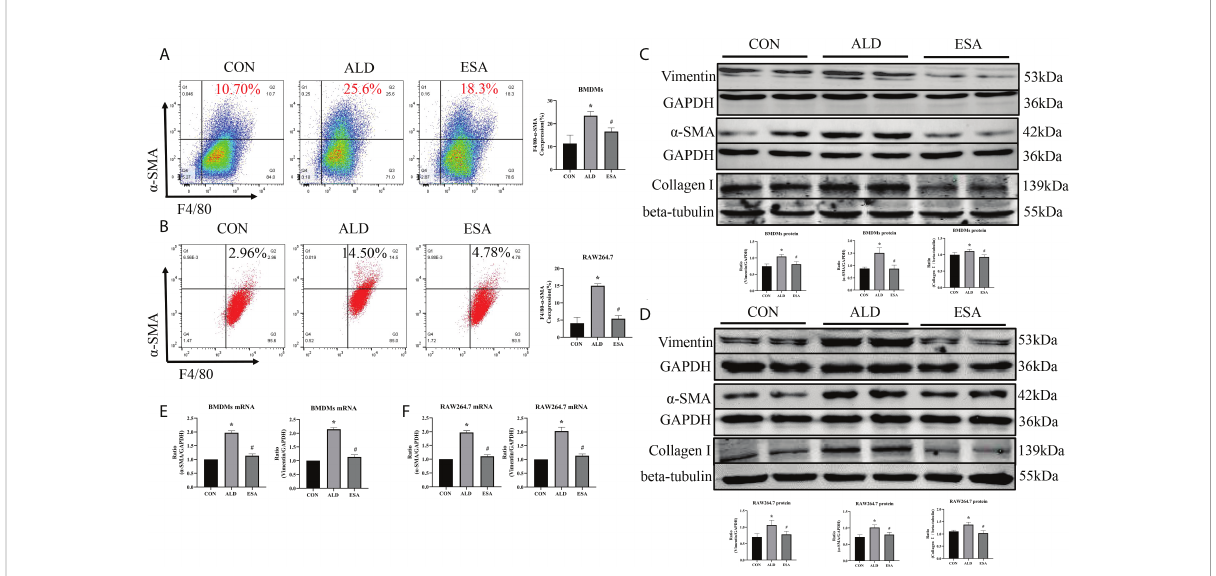
FIGURE 4 ESA antagonized MMT in ALD-treated BMDMs and RAW264.7 cells. (A) Flow cytometric analysis of the expression of a -SMA in BMDMs, and Q2 shows the percentage of MMT cells that were a -SMA + and F4/80 + (n = 3). (B) Flow cytometric analysis of the expression of a -SMA in RAW264.7 cells, and Q2 indicates the percentage of MMT cells that were a -SMA + and F4/80 + (n = 3). (C) Western blotting analysis of a -SMA, vimentin, and collagen I in BMDMs (n = 6). (D) Western blotting analysis of a -SMA, vimentin, and collagen I in RAW264.7 cells (n = 6). (E) The mRNA expression of a -SMA and vimentin in BMDMs (n = 6). (F) The mRNA expression of a -SMA and vimentin in RAW264.7 cells (n = 6). The data are presented as the mean ± SD, *p < 0.05 vs. the CON group, # p < 0.05 vs. the ALD group. ESA, esaxerenone; MMT, macrophage-to- myo fi broblast transition; ALD, aldosterone; BMDMs, bone marrow-derived monocytes/macrophages.